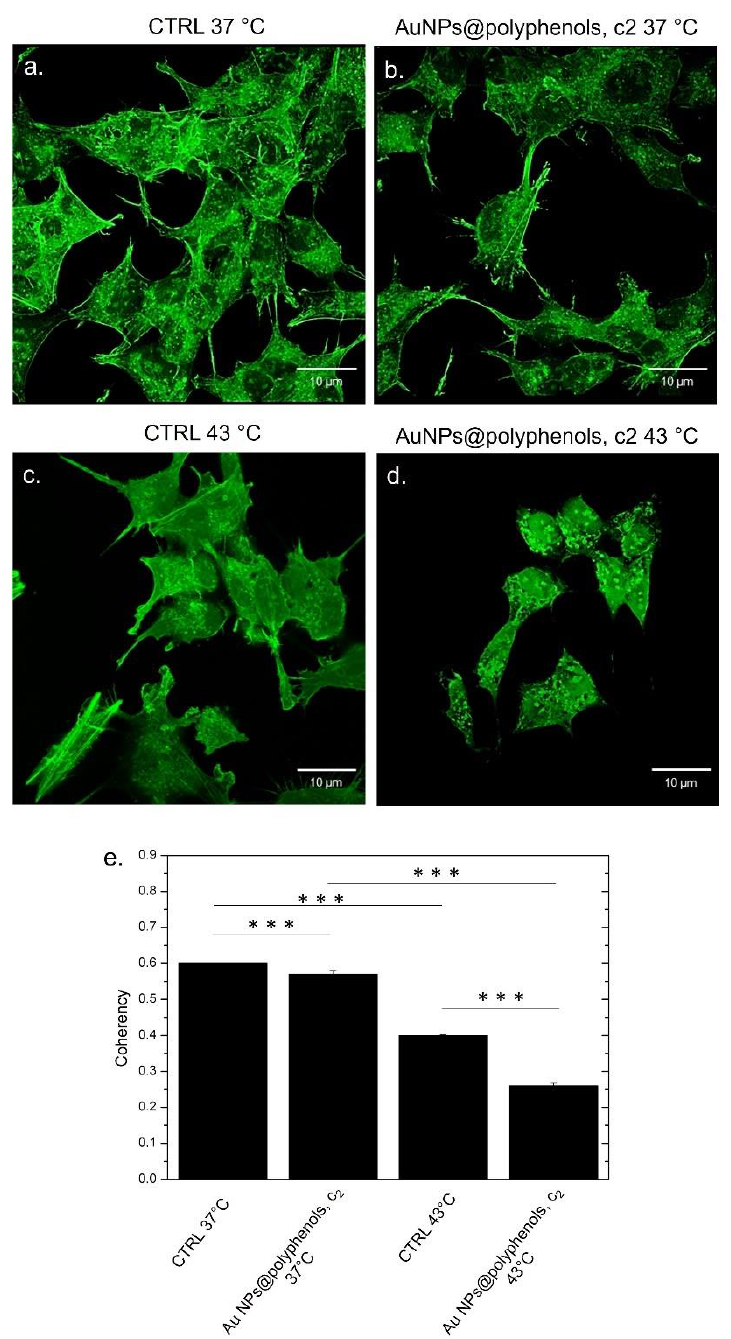
Figure 11. Effect of Au NPs@polyphenols on the actin network in SH-SY5Y exposed to the c2 of Au NPs@polyphenols at 37 ◦ C and 43 ◦ C for 48h, following the procedure described in the section, Materials (ph. 2.10). ( a ) untreated cells at 37 ◦ C; ( b ) cells incubated with Au NPs@poyphenols at c2 and 37 ◦ C; ( c ) cells treated with 43 ◦ C; ( d ) cells treated with heat and Au NPs@polyphenols at 43 ◦ C. The cells were fixed and then stained with Phalloidin–FITC. 2D images of cortical actin were acquired using a Zeiss LSM700 (Zeiss) confocal microscope, equipped with an Axio Observer Z1 (Zeiss) inverted microscope, using a ×100, 1.46 numerical aperture oil immersion lens. All data were processed using the ZEN software. ( e ) The coherency values calculated on the confocal acquisitions ( a – d ) were expressed as the mean value and relative SD using ImageJ (calculation on 15 cells). The mean values and their standard deviations are reported in the histograms. Data were statistically significant for *** p < 0.0001.